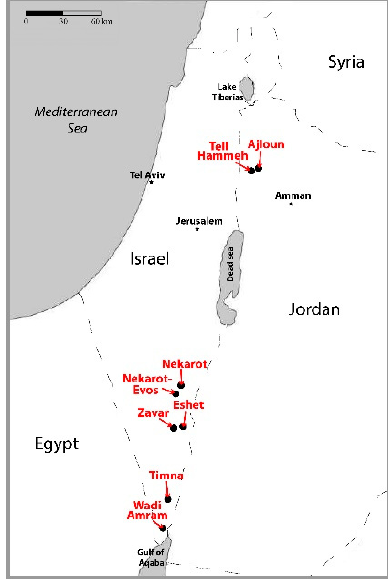
Figure 1. Location of iron ore deposits and occurrences of Southern Levant . Negev : Nekarot, Nekarot-Evos, Zavar, Eshet; Arabah : Timna, Wadi Amram; Ajloun . Table 1. Iron ores selected for assaying experiments, morphology, and mineralogical composition identified by FTIR, XRD, OM, and SEM. Sample